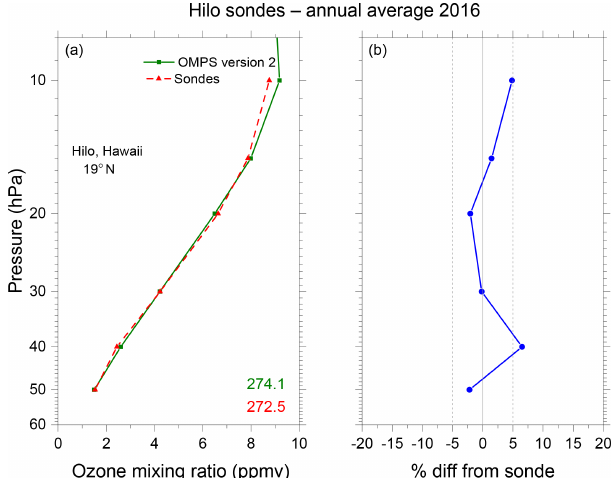
Figure 6. In version 2 the 4-year average of March ozone latitude dependence (2013–2016) is shown in (b) for the mapper (dashed blue curve) and for the profiler (solid red curve). Percent differences from MOD are shown in (a) .